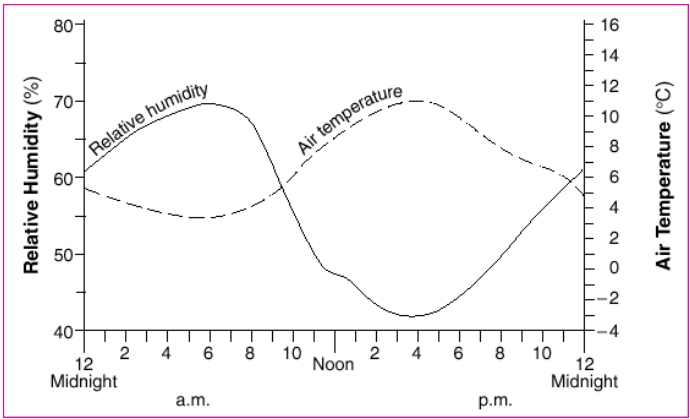
Figure 10. Relationship between relative humidity and temperature.